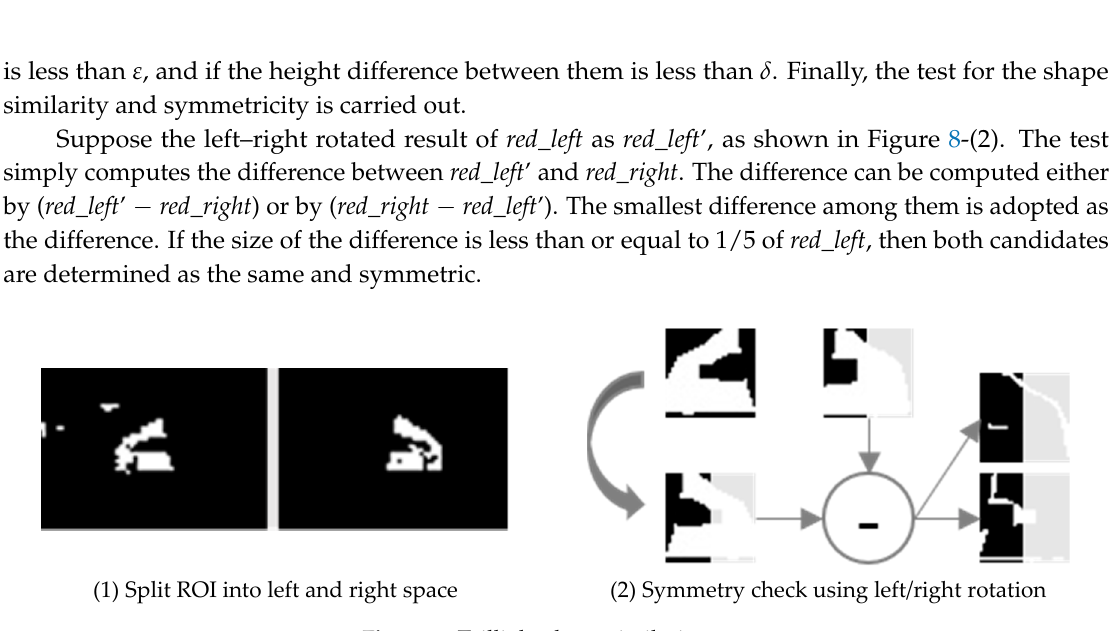
Figure 8. Taillight shape similarity test.